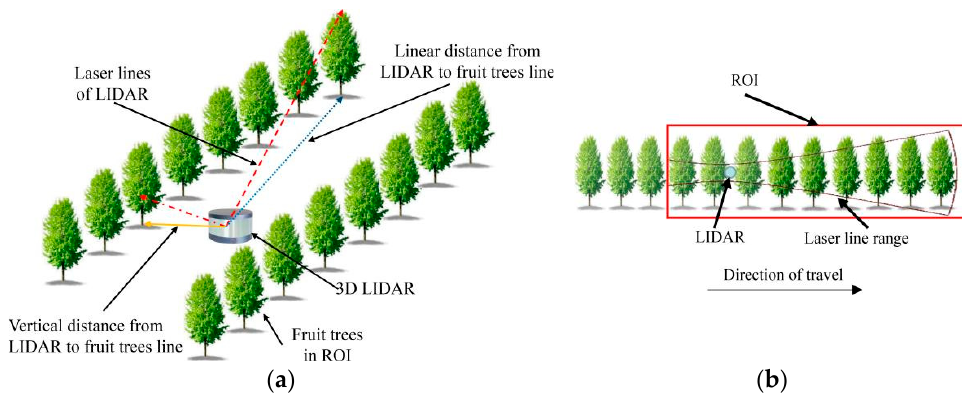
Figure 6. Determining the range of the ROI. ( a ) Three-dimensional view; ( b ) left